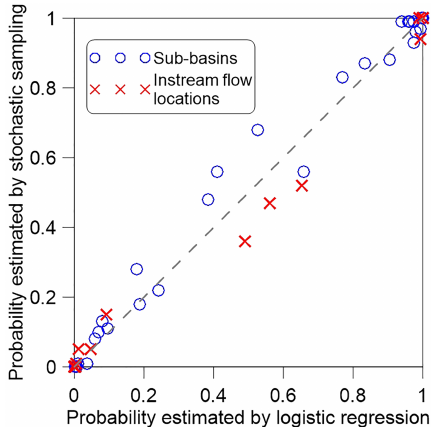
Figure 8. 1 : 1 plots between the probability estimates from the stochastic sampling and those from the logistic regressions for the case study. The probabilities of satisfactory performance at the 14 sub-basins and the seven instream flow locations were estimated by the 100 Monte Carlo simulations for each climatic perturbation. The number of points for comparison to the logistic models be- comes 63 (3 (perturbations) × 21 (locations) =